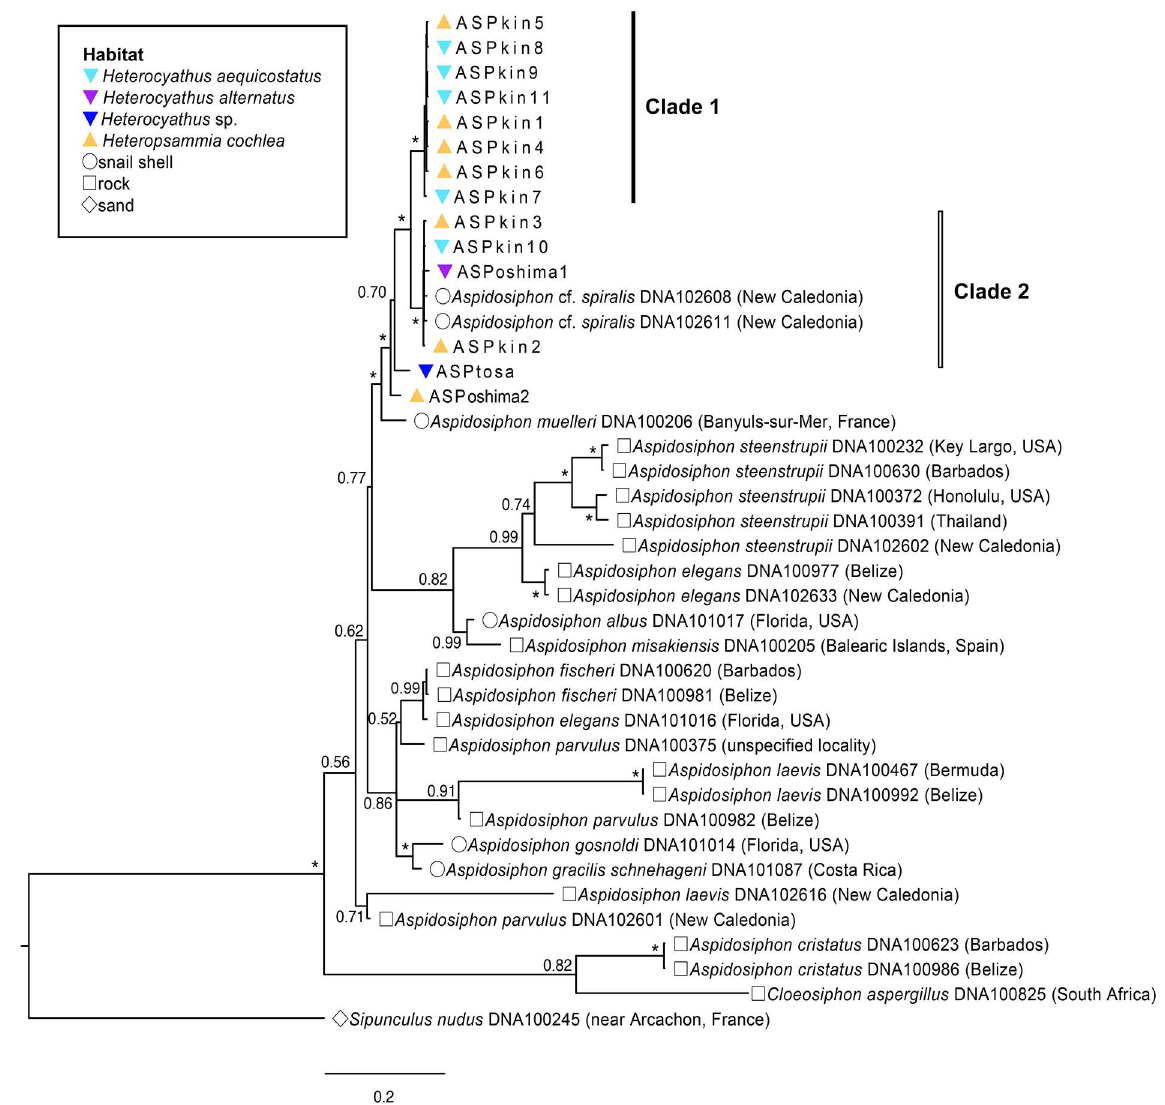
Fig 4. Bayesiantree of Aspidosiphon sipunculans based on the combined data set of five gene regions. Numbers on nodes indicateBayesianposterior probabilities. Asterisks correspondto PP = 1.00. ASPkin1–11, ASPoshima1–2, and ASPtosa are sample numbers given to the specimenscollected from Kin Bay, Oshima Strait, and Tosa Bay, respectively. Each symbol to the left of species names indicatessipunculan domicile.The accession number and the provenanceof each specimenare also